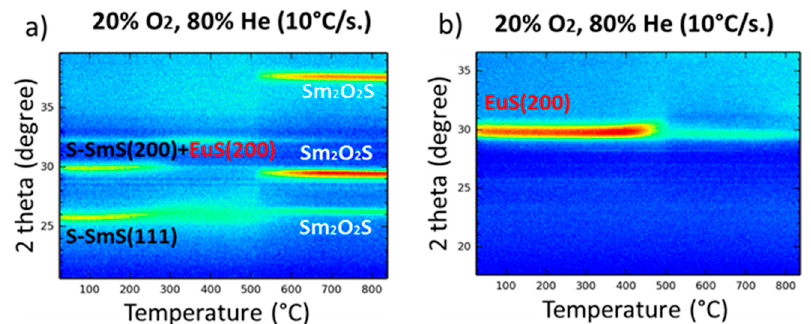
Figure 4. ( a ) In situ XRD patterns for increasing temperature of an as-deposited 35/30/35 nm SmS / EuS / SmS tri-layer in an ambient-like atmosphere of 20% O 2 and 80% He. ( b ) Same as in ( a ) for an as-deposited 25 nm EuS thin film on Si. Both thin films were deposited at 250 °C.